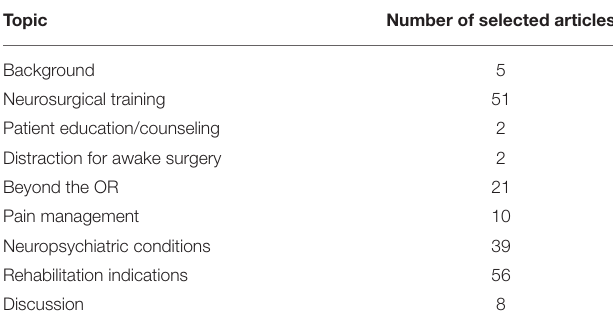
TABLE 1 | Breakdown of the number of articles referenced in each